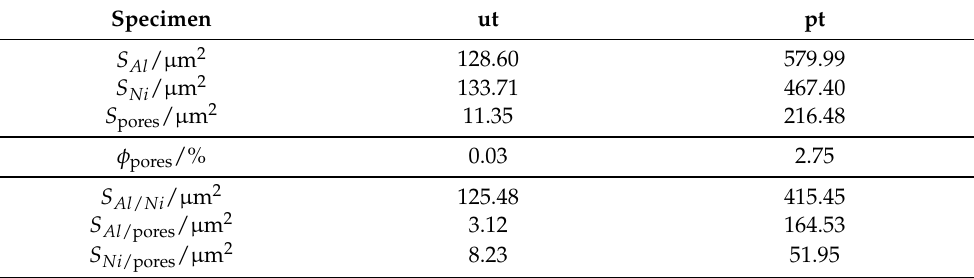
Table 1. Shape parameters of the untreated (ut) and the pre-treated (pt) volume, with surface S i of the phase i , volume fraction of the pores φ pores and the shared surfaces S i / j of both phases i / j . Specimen ut pt S Al / µ m 2